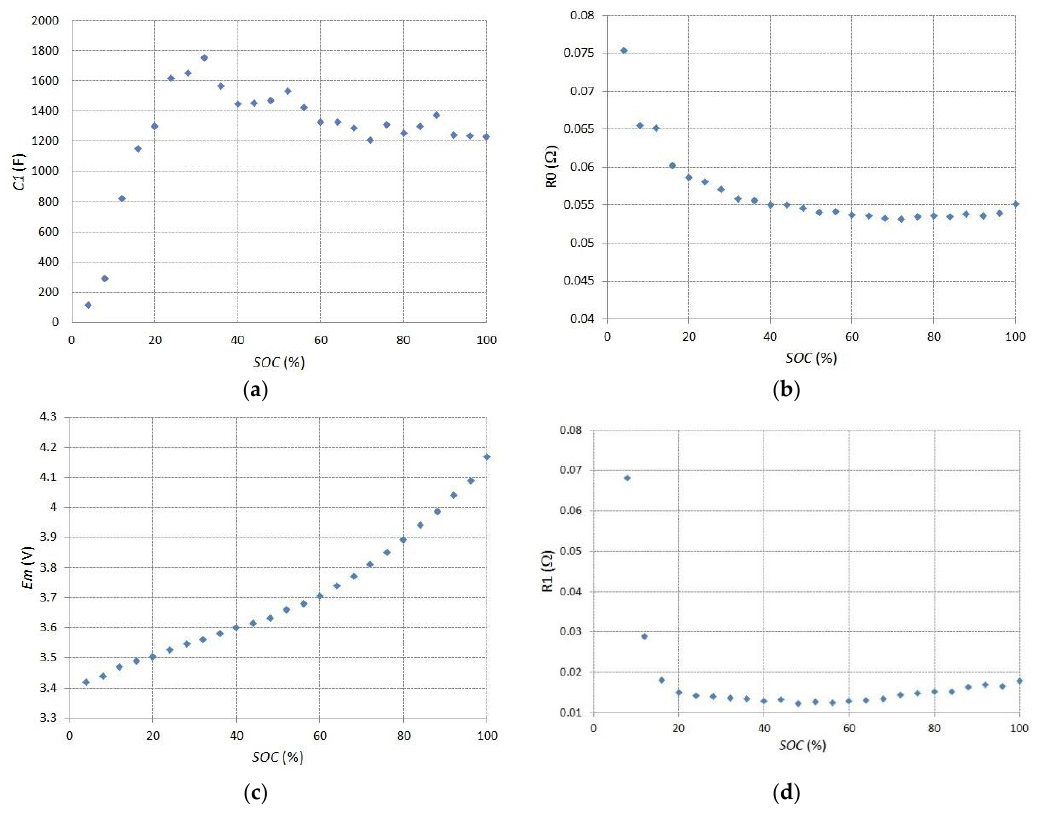
Figure 6. Relationships between: C 1 ( a ), R 1 ( b ), E m ( c ), R 0 ( d ) of equivalent circuit parameters and SOC .